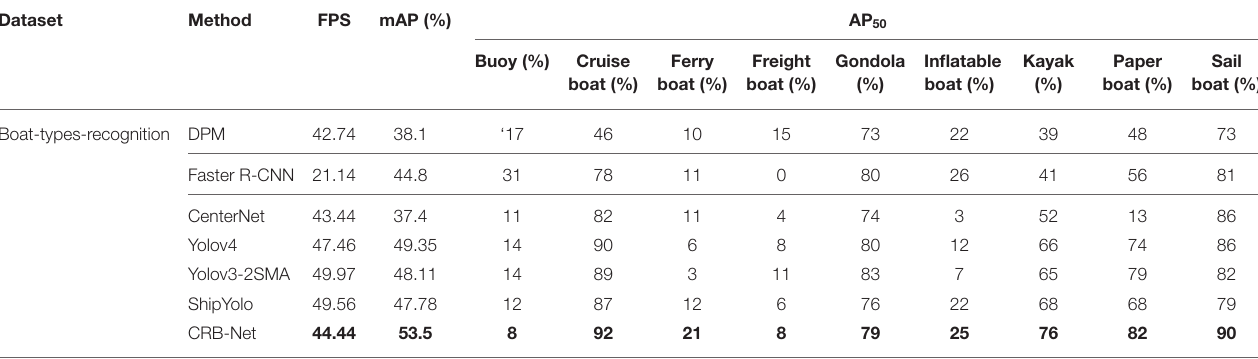
TABLE 6 | Results of cross-dataset generalization. Dataset